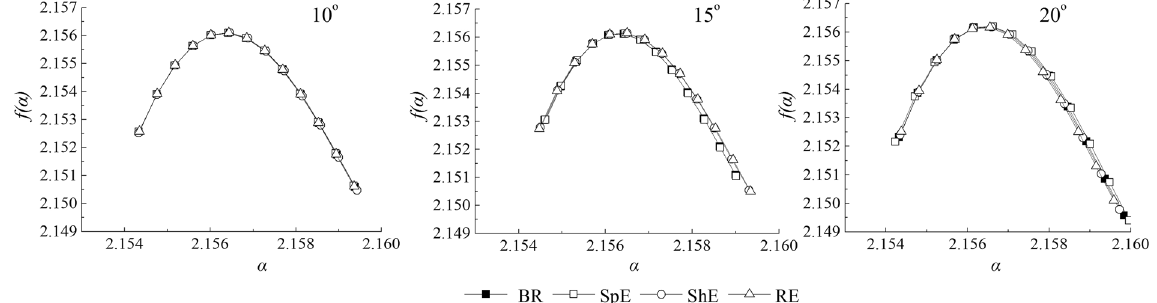
Figure 5. MFS of surface elevation at different erosive stages on different slope gradients.